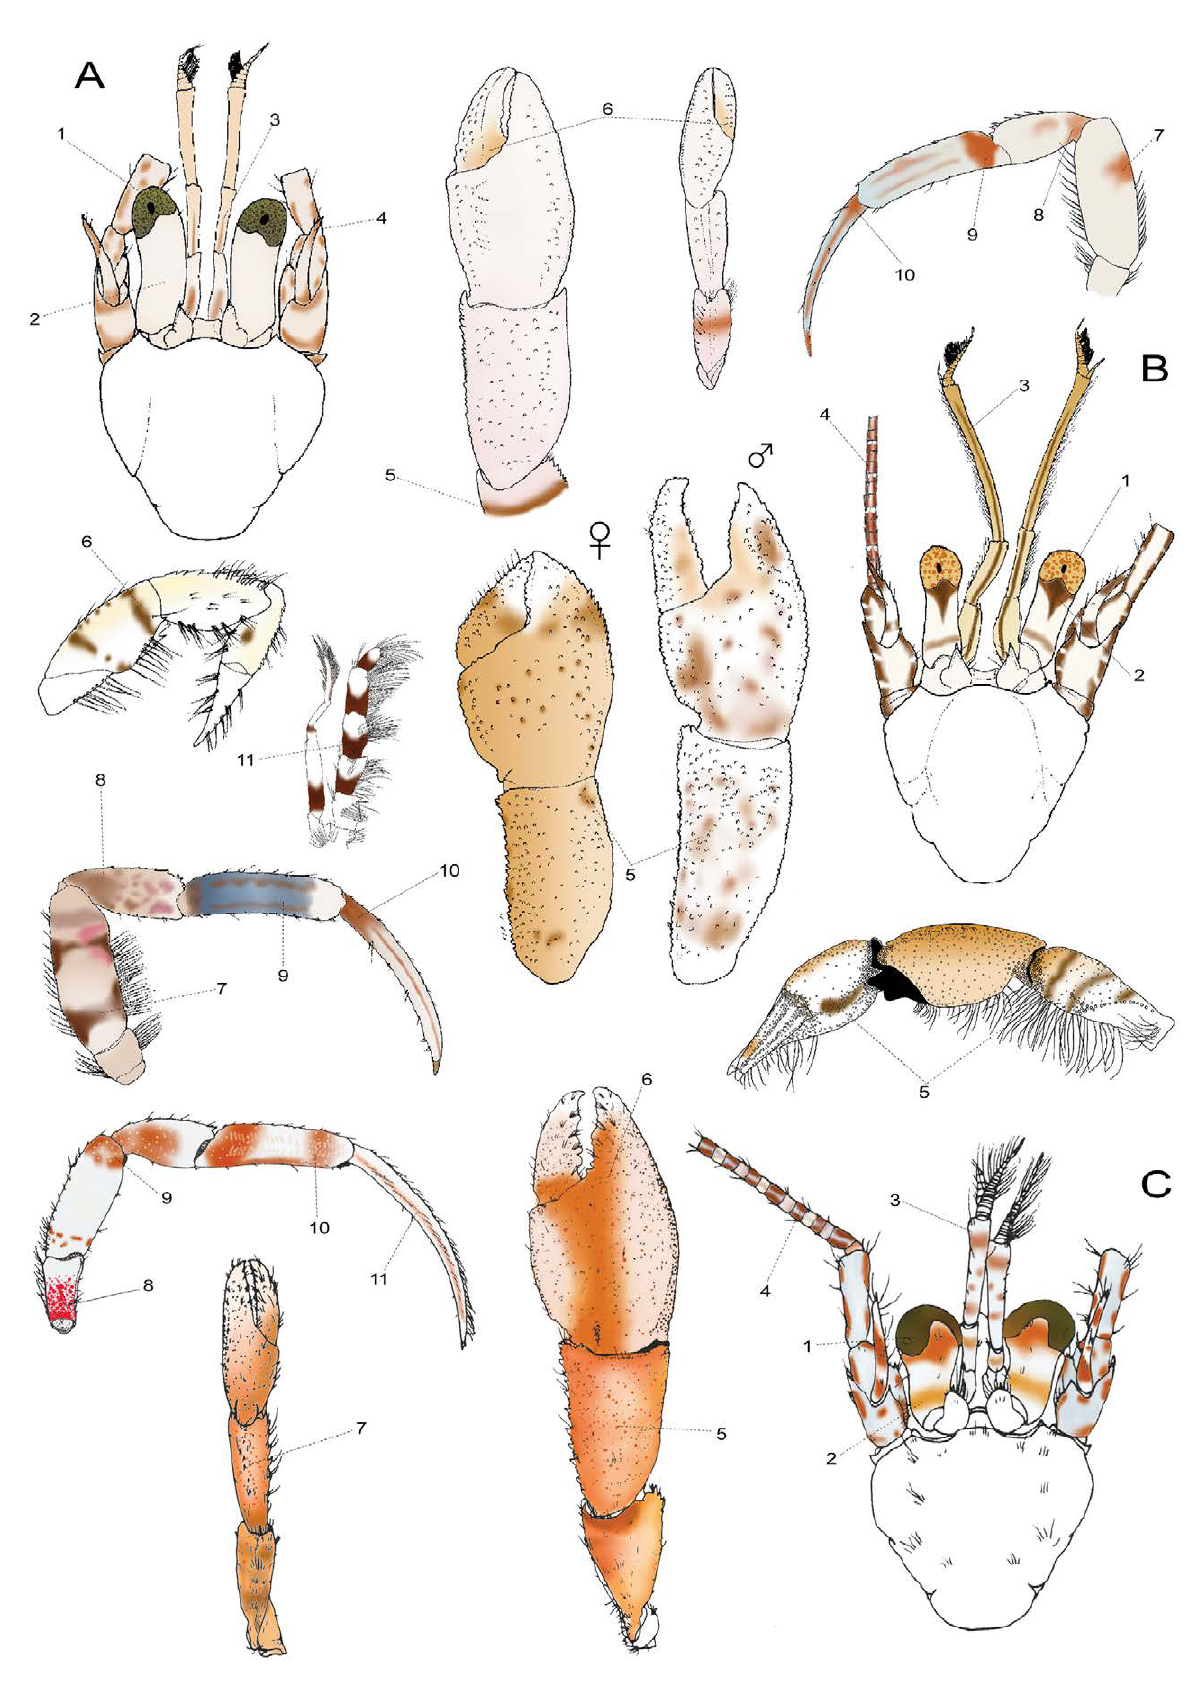
Fig. 5. – Colour patterns of Anapagurus species: A. curvidactylus (A, 1-10); A. hyndmanni (B, 1-11); Anapagurus laevis (C, 1-11). All vectorial drawings modified from Ingle (1993) except dorsal view of right cheliped in B (present